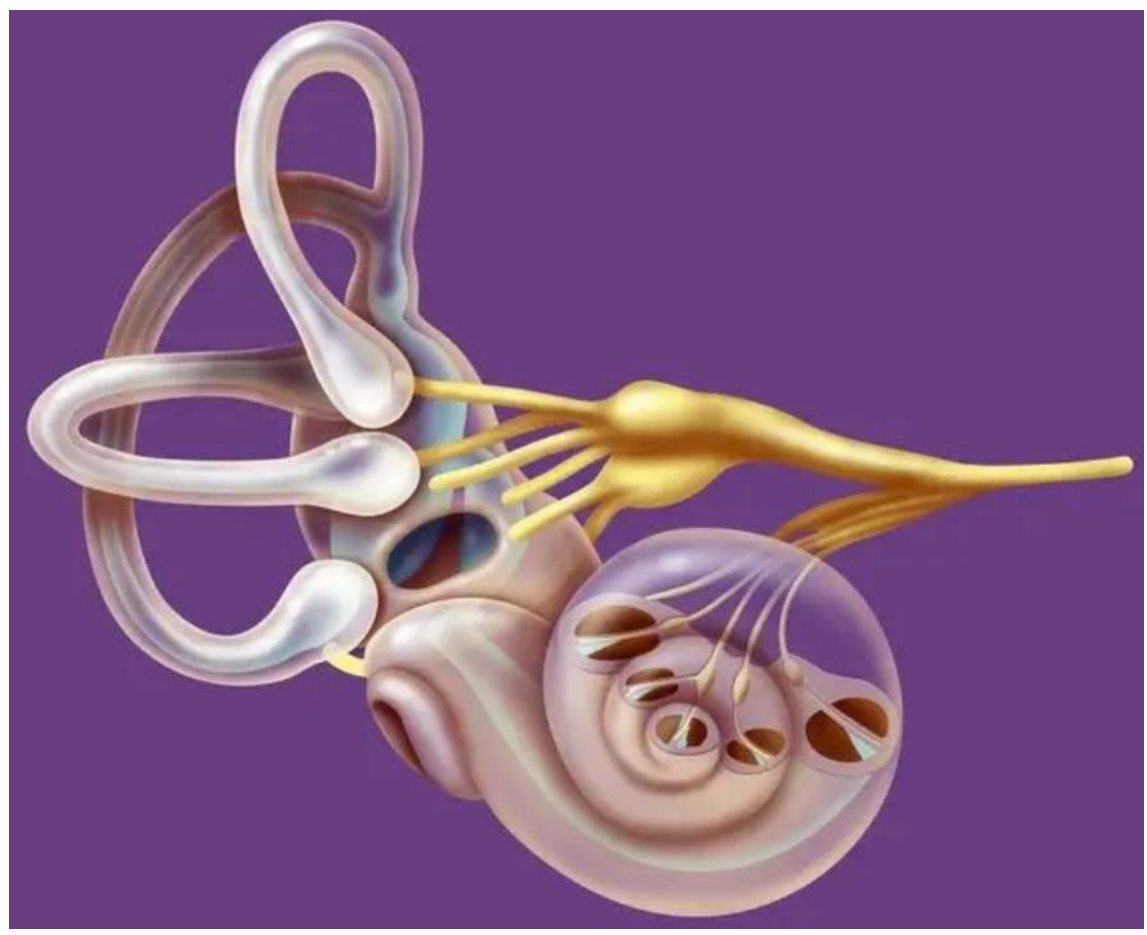
Figure 2. Structure of the inner ear of a fish. Image Credits: Youyulehao. The auditory characteristics vary between different fish species [31,32]. Most fish can hear sounds ranging from 50 to 1000 Hz, a few fish can hear sounds greater than 3 kHz, and only a few fish can hear sounds greater than 100 kHz [33]. The auditory sensitivity of